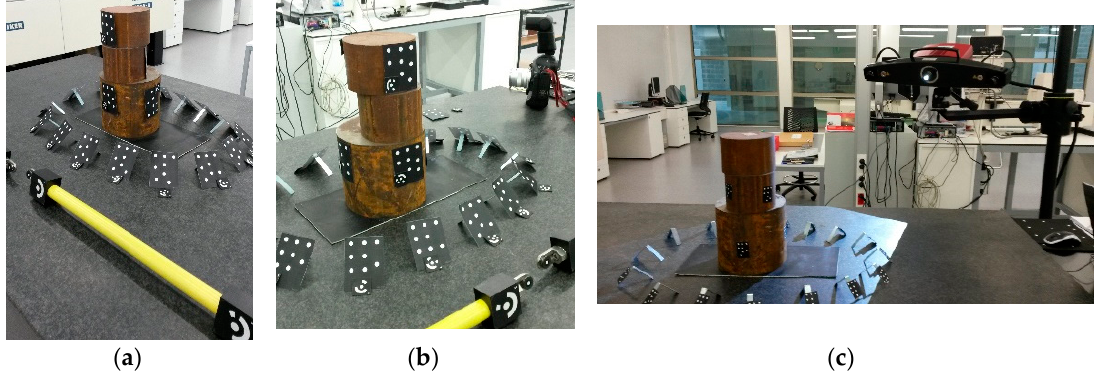
Figure 11. Measuring method for reference data determination in lab: ( a ) scene preparation with coded targets (ring and dot type) and scale bar; ( b ) photogrammetric camera (TRITOP©); and ( c ) structured light 3D scanner (ATOS IIe©).